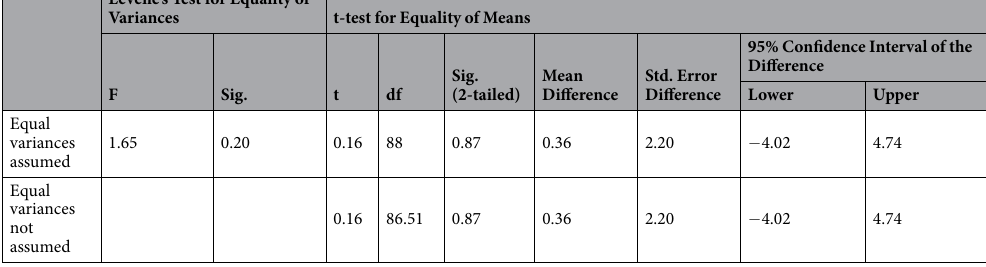
Table 6. The independent-samples t -test for field and remote sensing derived